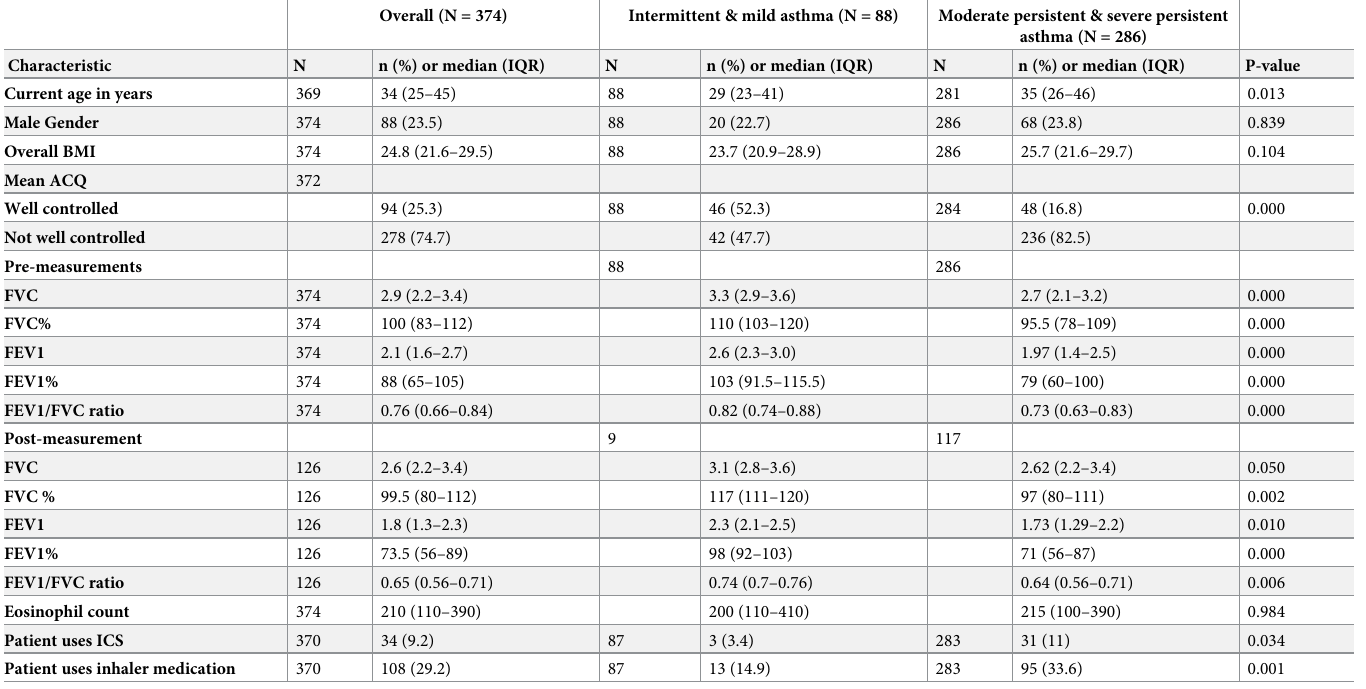
Table 2. Selected baseline characteristics of the study population.